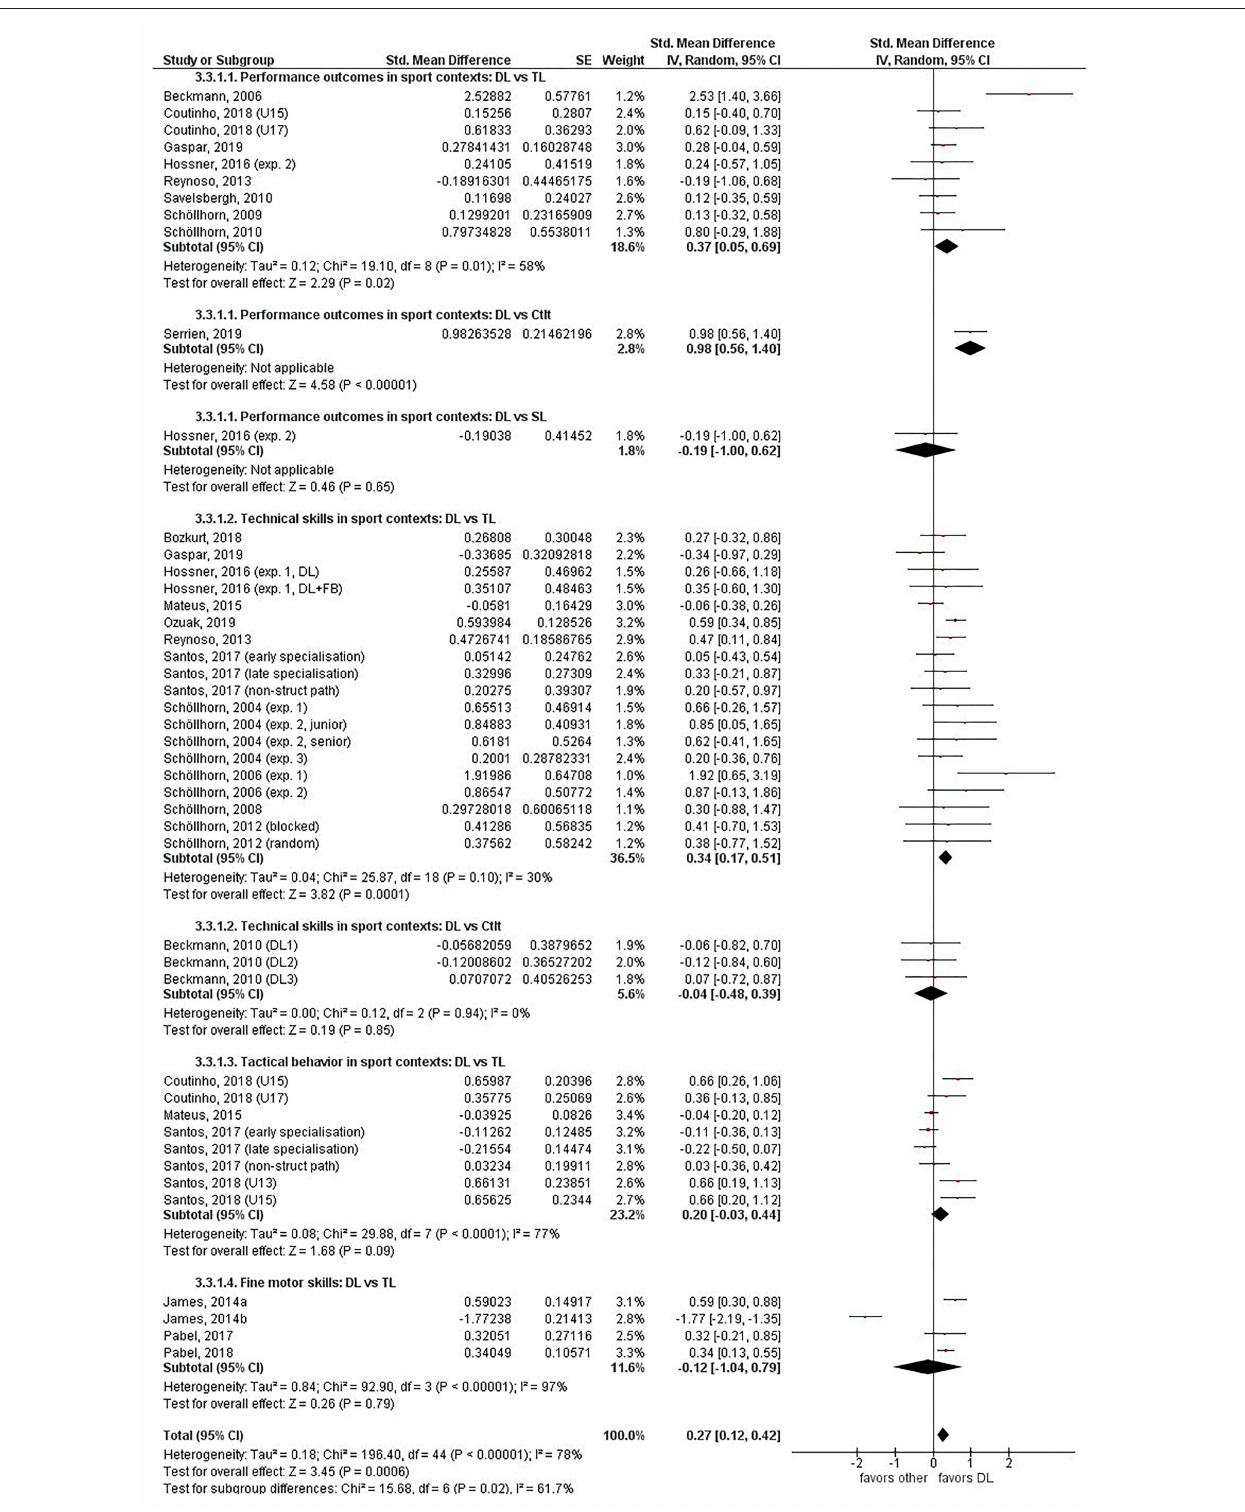
Frontiers in Psychology |